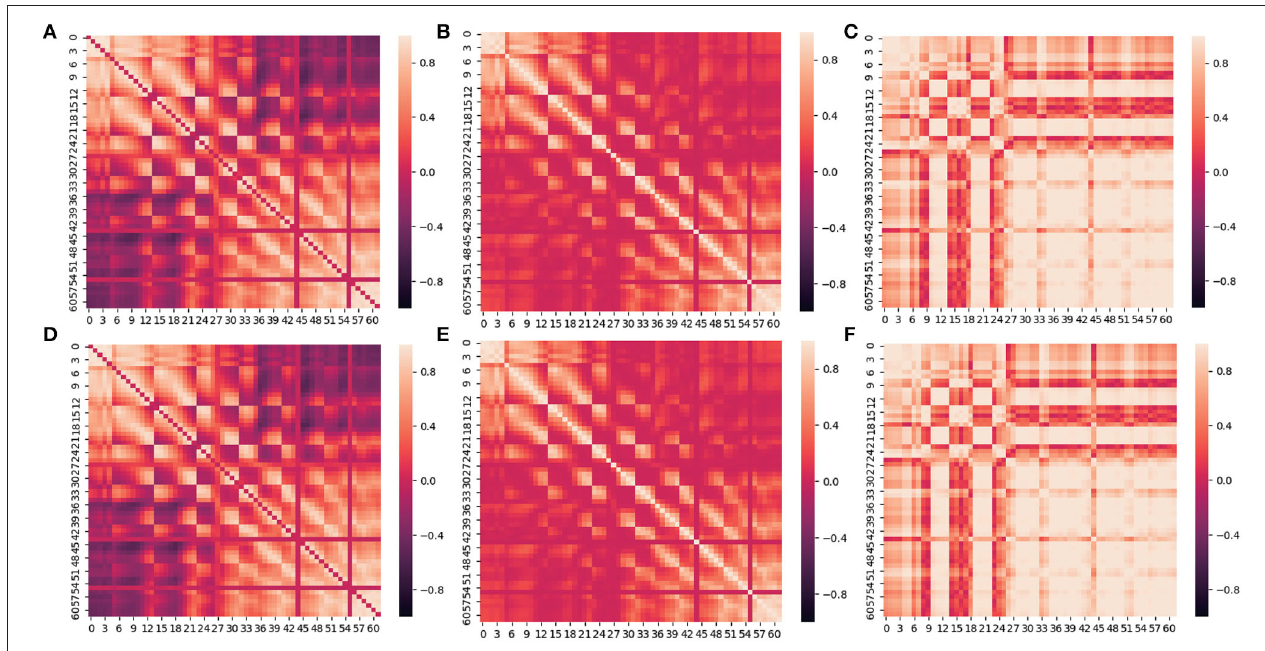
FIGURE 5 | Between-channel FC visualization of PCC and Comprehensive. (A–C) is the heat map of PCC, Coherence and PLV. (D–F) is the heat map of Comprehensive based on (A–C) .